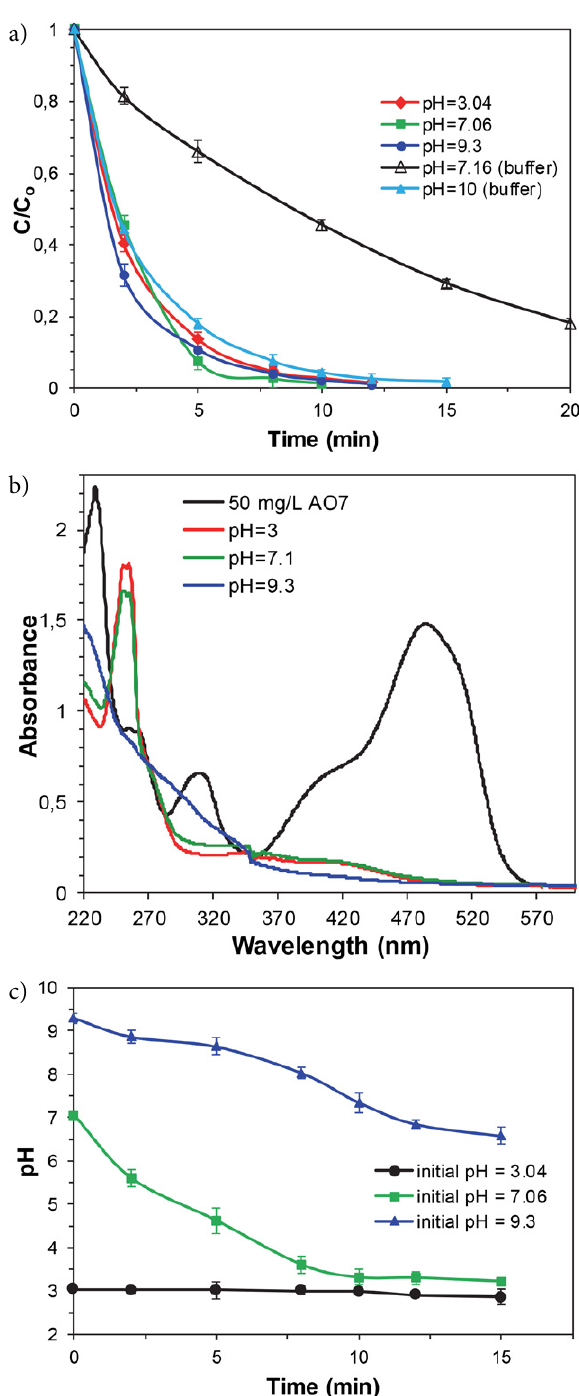
Fig. 13. Performance of 50% Bi 2 O 3 -Co 3 O 4 for AO7 degradation with PMS at different initial pHs: (a) AO7 degradation; (b) UV–vis spec- tra of the AO7 aqueous solution at 12 min ; (c) Changes of pH over time in the case of different initial pH values. Reaction conditions : [AO7] o = 50 mg/L; [PMS]/[AO7] = 6; [Catalyst] = 0.1 g/L; T = 293